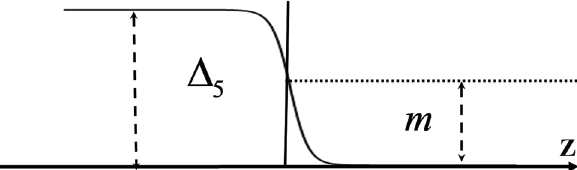
Figure 6. Proximity induced generation of Majorana fermions in Δ 5 | m setting. The right side (green) is a 3DDM which is not superconducting in the absence of a conventional superconductor (dark blue) to its